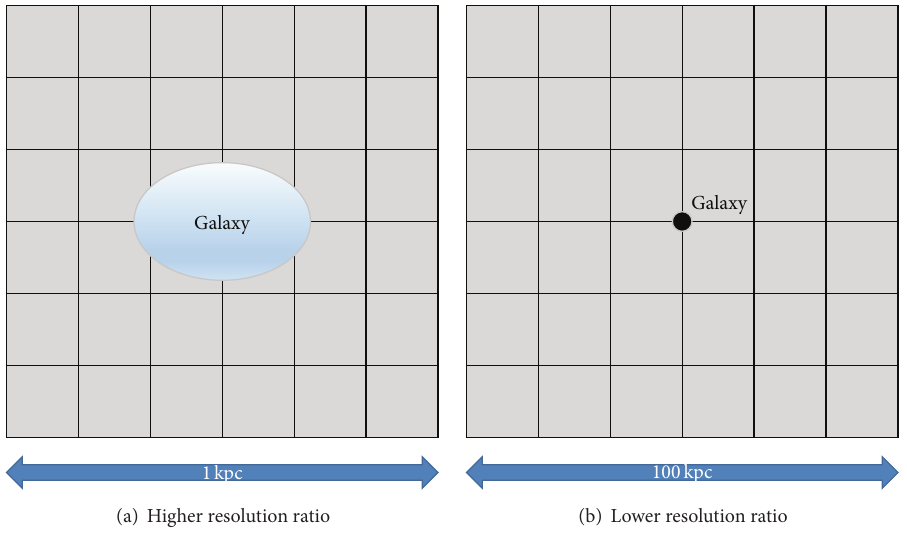
Figure 2: Illustration of multistage particle-mesh scheme.